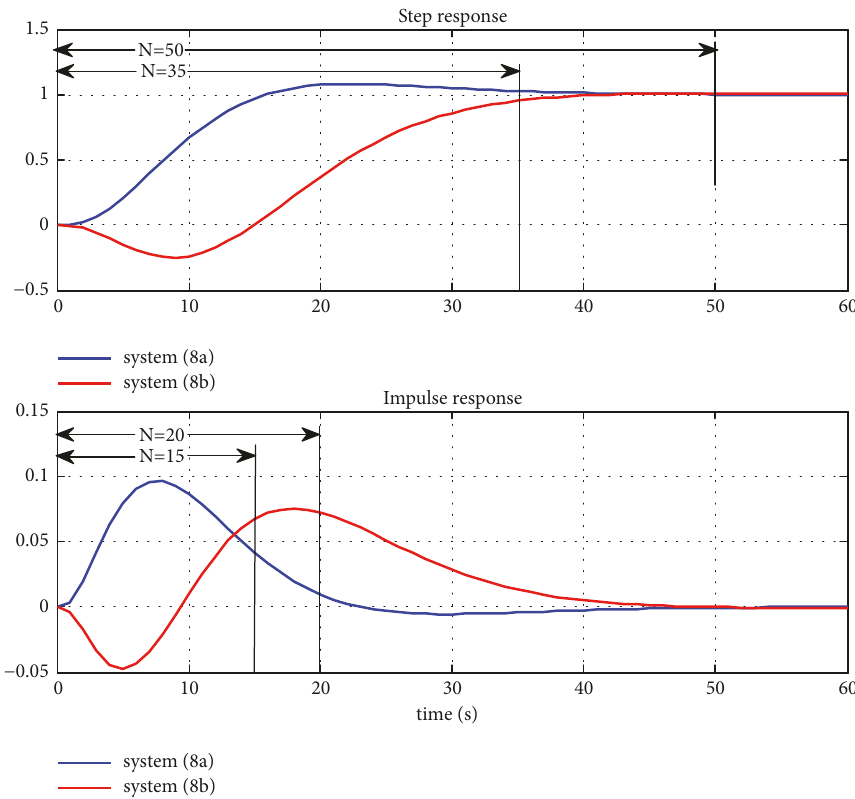
Figure 1: Characteristics of controlled